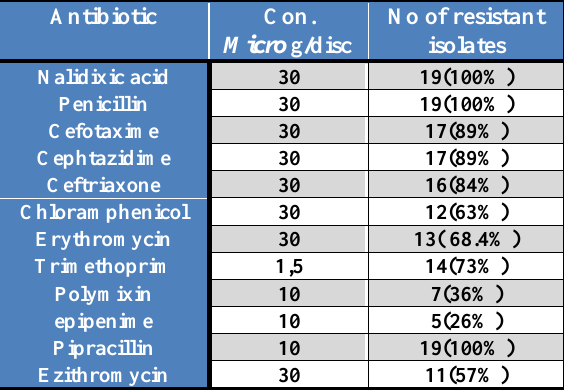
Table, 3: Antibiotic sensitivity test of P. aeruginosa isolates in sheep.